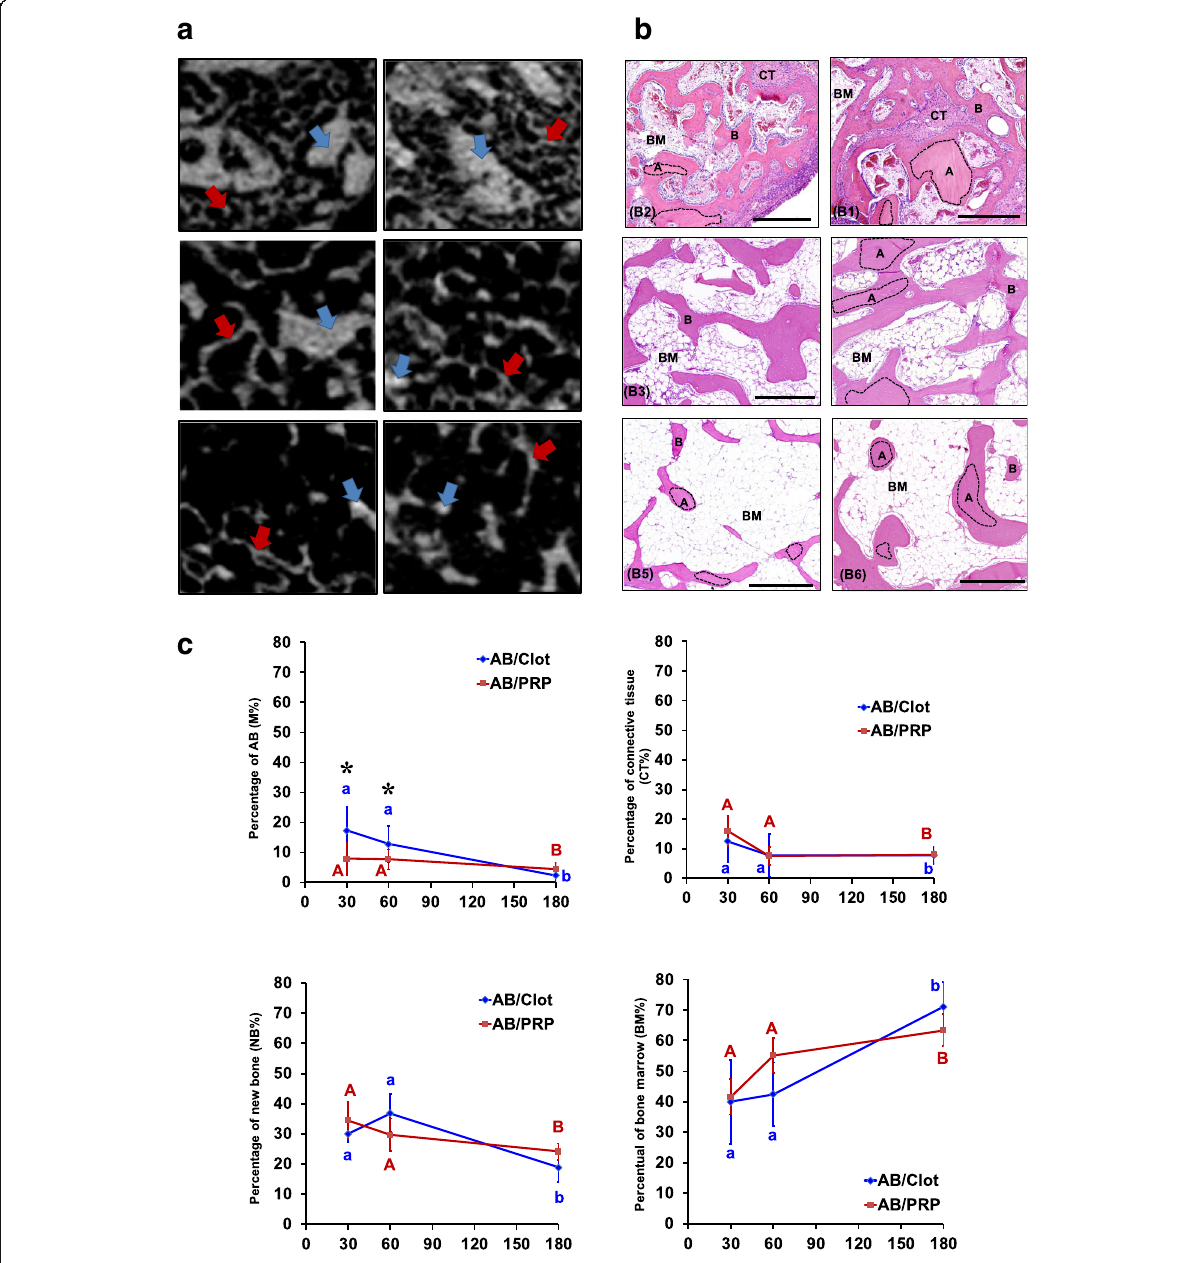
Fig. 3 MicroCT and histomorphometric results for AB group. a 2D-microCT view: the images show large AB particles (blue arrow) and many fine trabeculae of new bone (yellow arrow) between particles at 30 days. Between 30 and 180 days, reduction of AB particles (blue arrow) and thickening and reduction of the number of bone trabeculae occur. b Histological view at 30 days, AB particles (area surrounded by black dotted line) are surrounded by bone (yellow arrow) and the spaces between them filled by connective tissue (CT) and bone marrow (BM). Note that at 60 and 180 days, the new formatted bone and AB particles reduces and most of the space between the particles was replaced by bone marrow (BM). HE; 10, c ) Percentage of each constituent: graphs of evolution of M% ( C1 ), CT% ( C2 ), NB% ( C3 ), and BM% ( C4 ) in MSA of AB/clot and AB/ PRP. Different letters p < 0.05 among periods per group and asterisks difference between